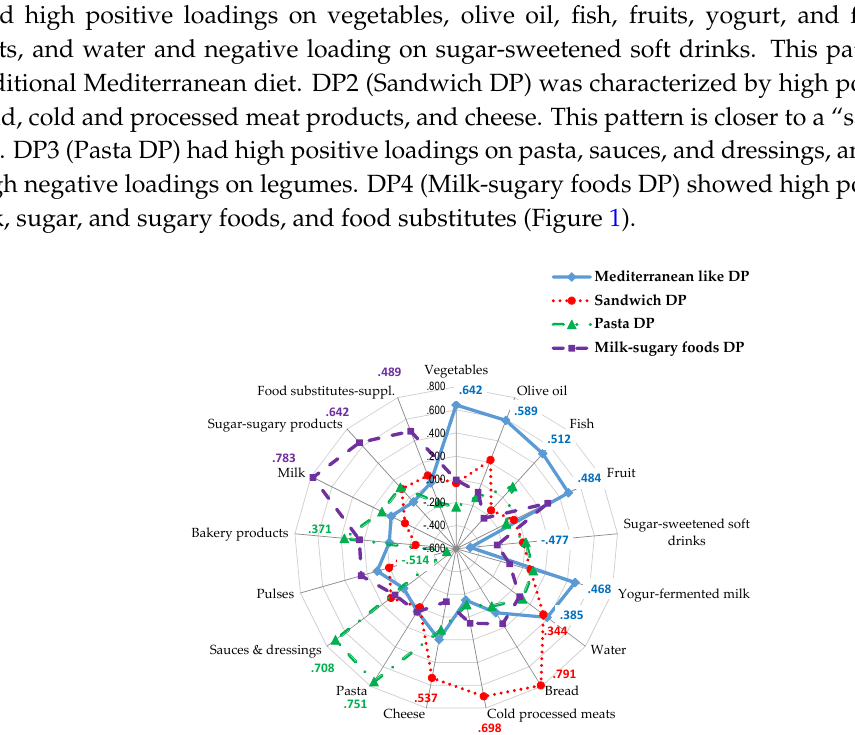
Figure 1. Factor loadings after varimax rotation on identified dietary patterns of food groups retained. Eigenvalues: Mediterranean like Dietary Pattern (DP) = 2.13; Sandwich DP = 1.74; Pasta DP = 1.57; Milk-sugary foods DP = 1.54. % variance explained: Mediterranean like DP: 11.37%; Sandwich DP: 10.0%; Pasta DP: 9.85%; Milk-sugary foods DP: 9.80%. Total variance explained 41.03%. Absolute values less than 0.30 are not shown. Table 1. Gender, age group, family educational and SES levels, and BMI status, by lifestyle pattern a .